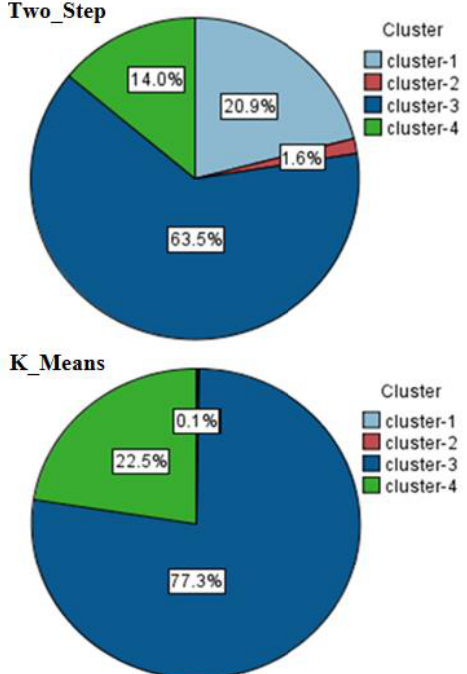
Figure 4: Two_Step and K_Means with 4 clusters.